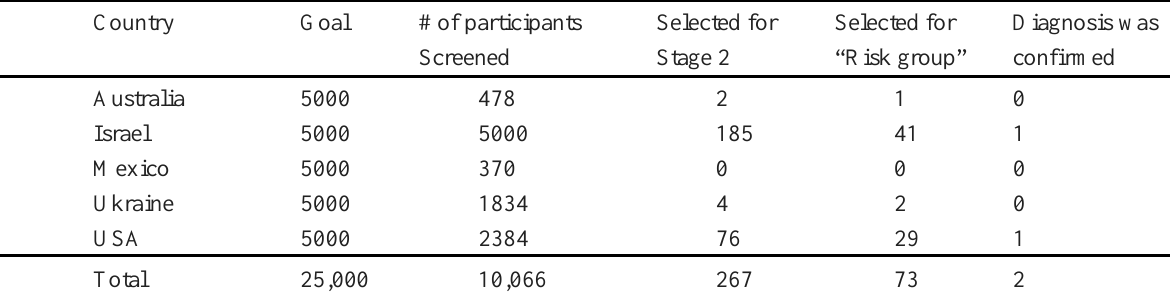
Table 1. Preliminary results of the research (for December 2018) country by country included in the